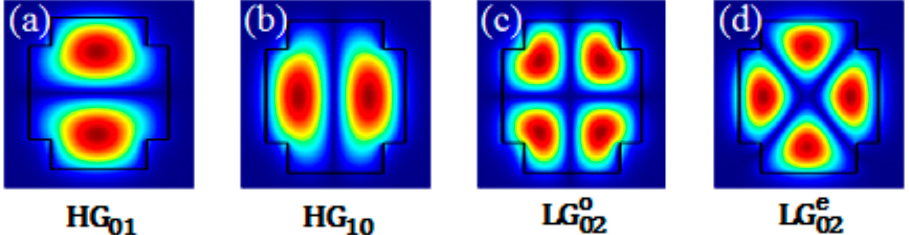
Figure 3. HG-similar mode field distributions in the designed waveguide. The mode effective indices (n eff ) of ( a ) HG 01 ; ( b ) HG 10 ; ( c ) LG o ; and ( d ) LG e are 3.215525, 3.215482, 3.05968, and 3.059751, respectively.